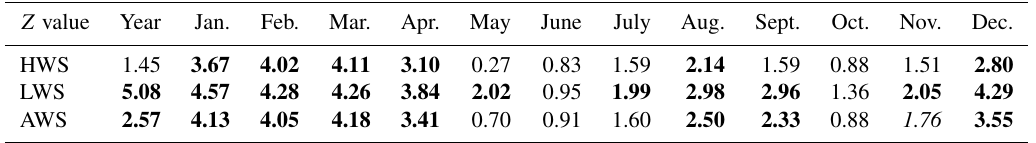
Table 2. Tendencies analysis of HWS, LWS, and AWS from 1954 to